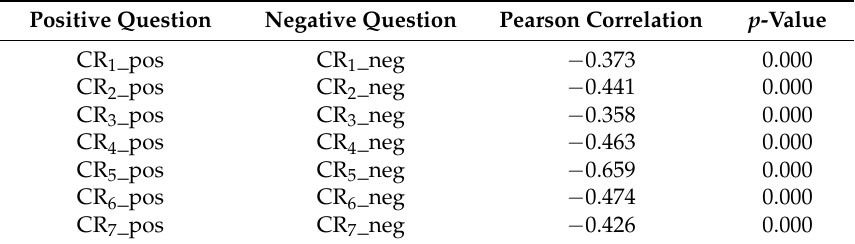
Table 6. Requirements of (non)linearity examination using correlation analysis.